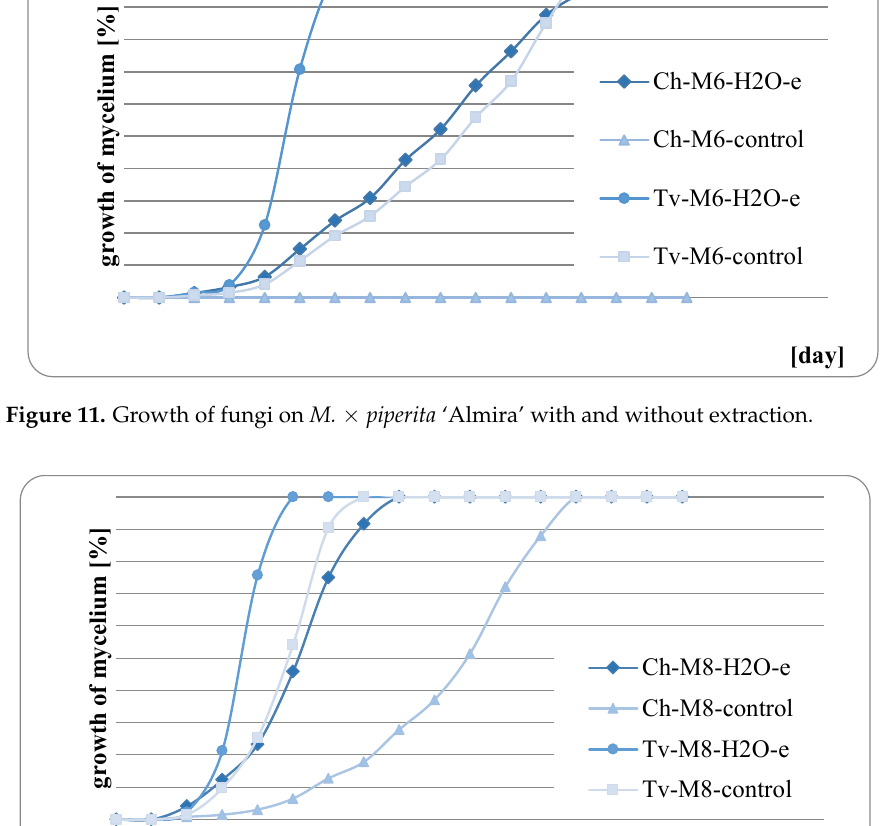
Figure 10. Growth of fungi on M. spicata ‘Crispa’ with and without extraction.